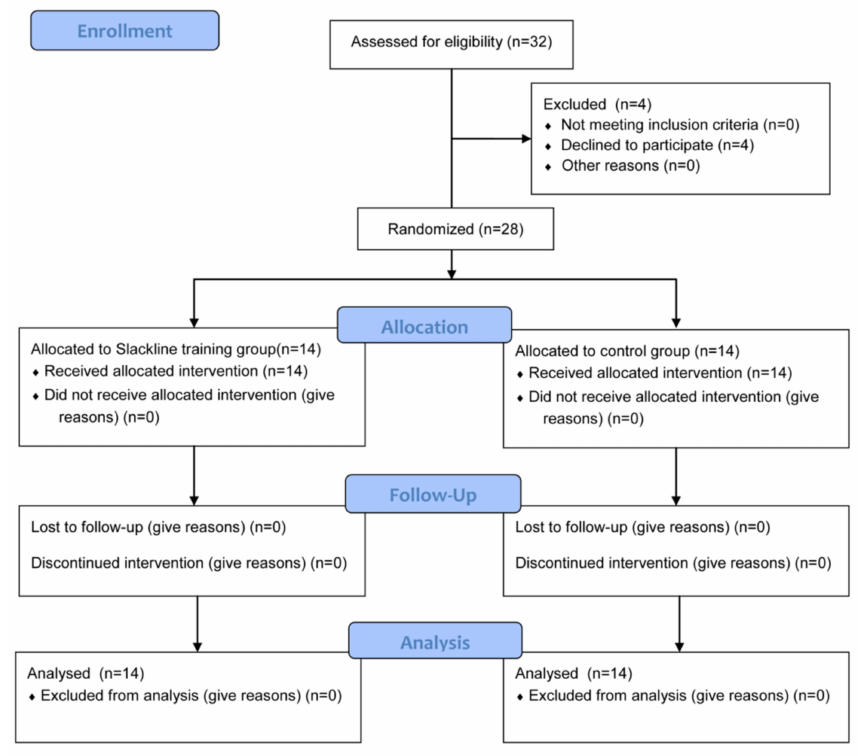
Figure 1. CONSORT flow diagram.